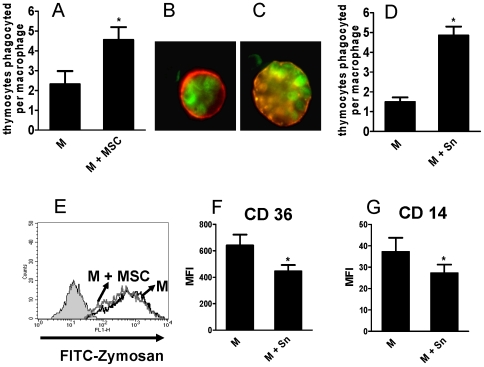
MSC stimulate the uptake of apoptotic thymocytes by M.M were cultured overnight in the absence or presence of MSC (M: MSC ratio 10∶1). Apoptotic thymocytes labeled with CFSE were then added (M: thymocyte ratio = 1∶10), and cells were incubated for 1 h at 37°C. The number of apoptotic thymocytes inside each macrophage was analyzed by fluorescence microscopy using PE-labeled IgG anti-CD11b. At least 200 macrophages were scored in each experiment. (A) Results are expressed as the number of thymocytes internalized per macrophage and represent the arithmetic mean ± SEM of five experiments. *, p<0.05 for M+MSC vs M. (B) Representative images of phagocytosis of apoptotic thymocytes by M cultured alone (B) or in the presence of MSC (C). (D) MSC grown to confluence were cultured alone for 24 h and the cell-supernatants were then harvested. M were cultured overnight with or without MSC supernatants (50% V/V). Apoptotic thymocytes labeled with CFSE were then added (M: thymocyte ratio = 1∶10), and cells were incubated for 1 h at 37°C. The number of apoptotic thymocytes inside each macrophage was analyzed as described above. Results represent the arithmetic mean ± SEM of four experiments. *, p<0.05 for M+Sn vs M. (E) M were cultured overnight in the absence or presence of MSC (M: MSC ratio 10∶1). FITC-labeled zymosan particles (250 µ/ml) were then added and phagocytosis was evaluated after 1 h of incubation at 37°C, using PE-labeled IgG anti-CD11b and flow cytometry, in the gate of CD11b-positive cells. Grey histogram represents the fluorescence of M cultured without zymosan particles. It was similar for M cultured in the absence or presence of MSC. A representative experiment (n = 4) is shown. (F and G) MSC grown to confluence were cultured alone for 24 h and the cell-supernatants were then harvested. M were cultured overnight with or without MSC supernatants (50% V/V). Cells were washed and the expression of CD36 and CD14 was analyzed by flow cytometry. Results are expressed as the mean fluorescence intensity (MFI) values and represent the arithmetic mean ± SEM of 4 experiments. *, p<0.05 for M+Sn vs M.